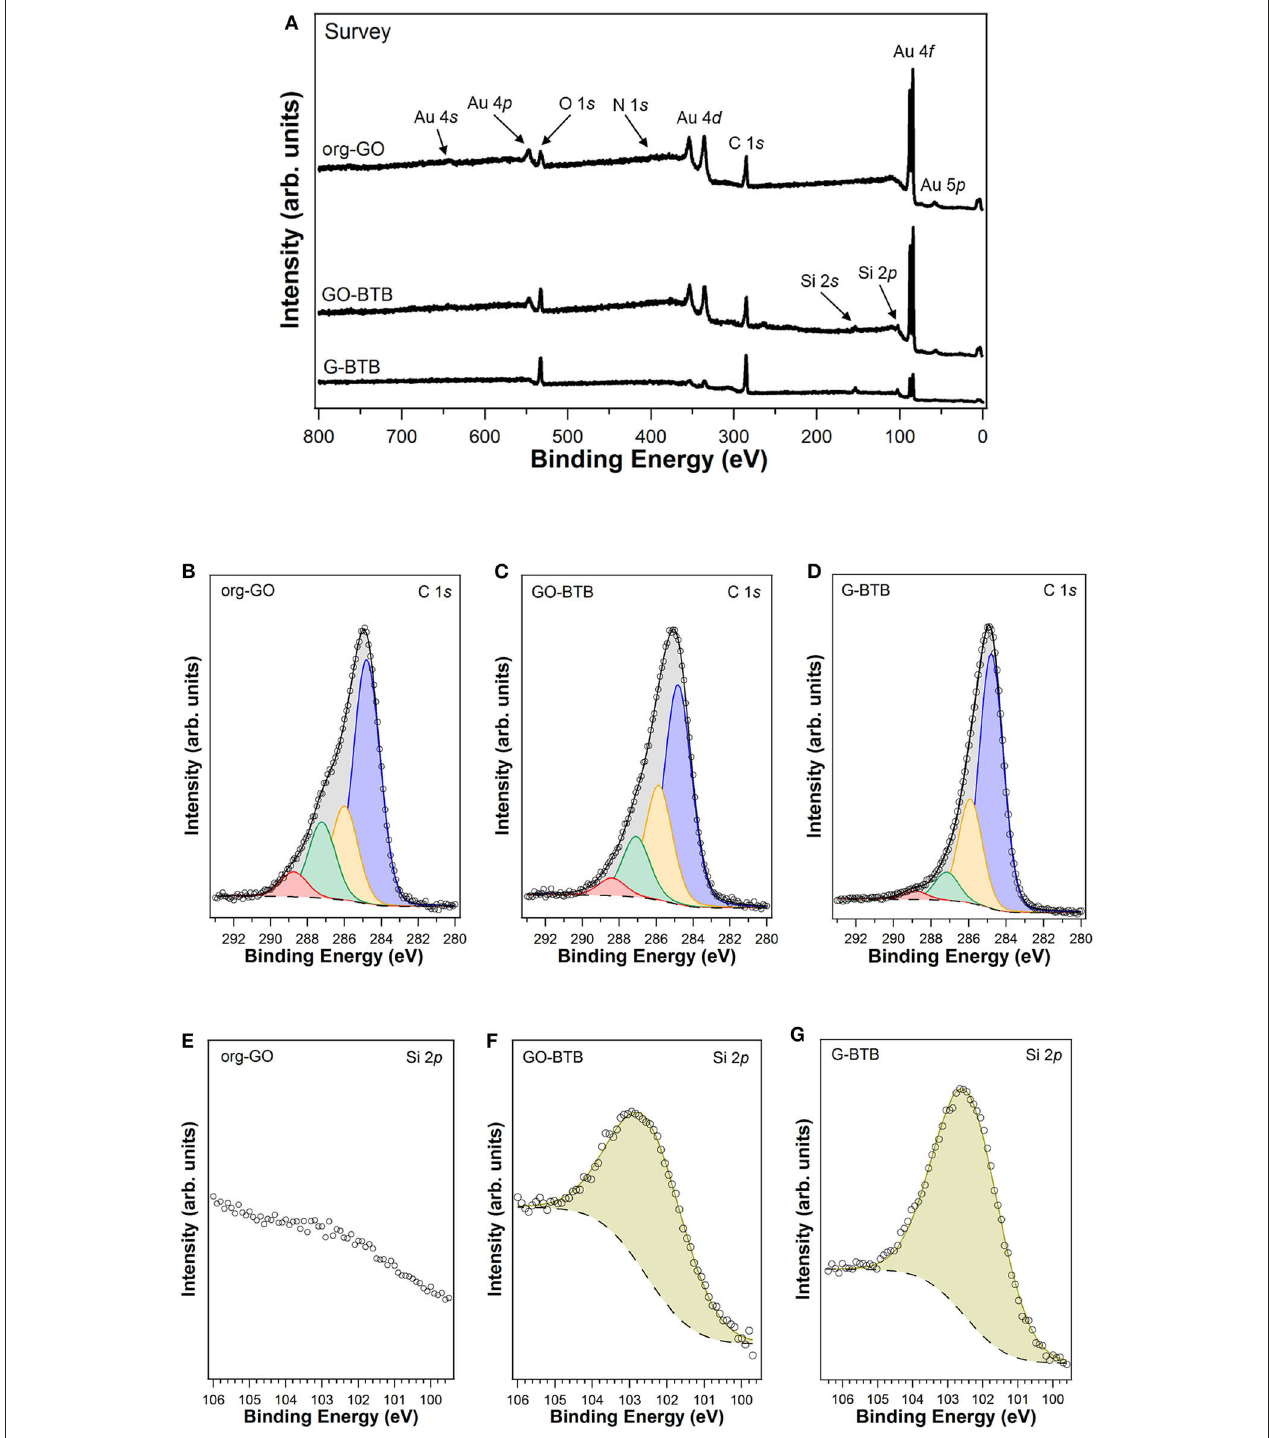
FIGURE 7 | Survey scan [top panel (A) ], C1 s (B–D) and Si2 p (E–G) XPS spectra of graphene oxide intercalated with dodecylamine before (org-GO), after silylation with 1,4-Bis(triethoxysilyl)-benzene (GO-BTB) and after subsequent calcination (G-BTB) (dots) and corresponding fits (full lines); for the differently colored peaks see text. PELLA), prepared by sublimation of 99.99 % gold (Schöne uncertainty in the peak intensity determination is 2 % for Edelmetaal B.V.) as detailed in Mendoza et al. (2007) were all core levels reported. For the measurements, evaporated polycrystalline gold films supported on mica (grade V-1, TED used as substrates. Thermogravimetric (TGA) and